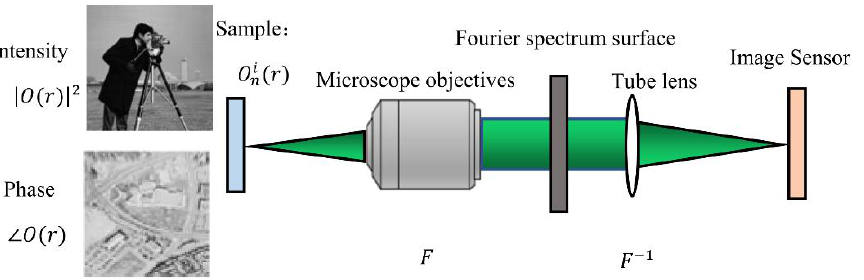
Figure 1. Schematic diagram of FPM imaging model.